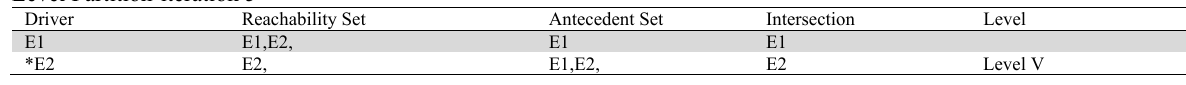
Level Partition-iteration 5